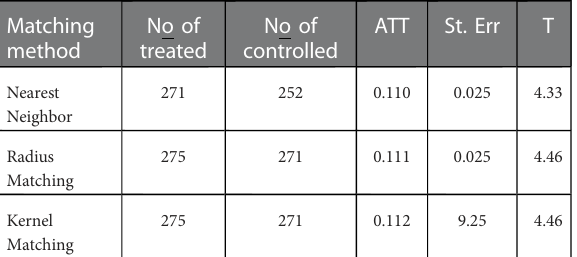
TABLE 4 The effect of staying in maternity waiting home on prenatal birth out come in east gojjam, NW Ethiopia, 2017. Matching method